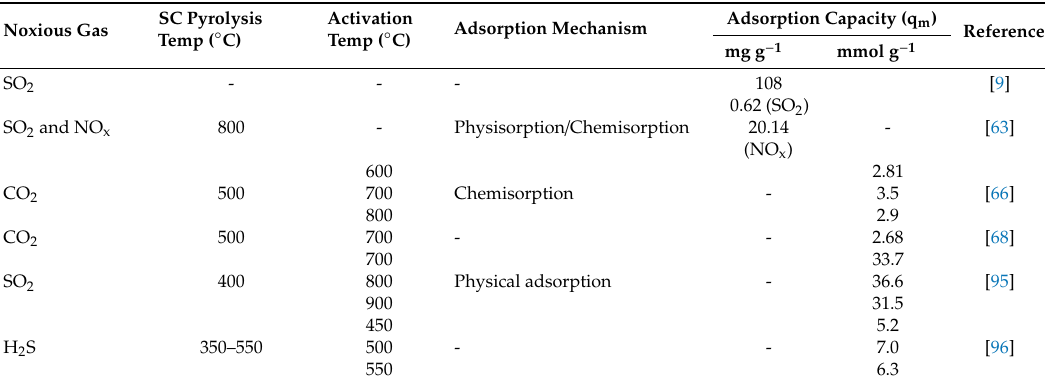
Table 5. Adsorption capacity of some noxious gases on